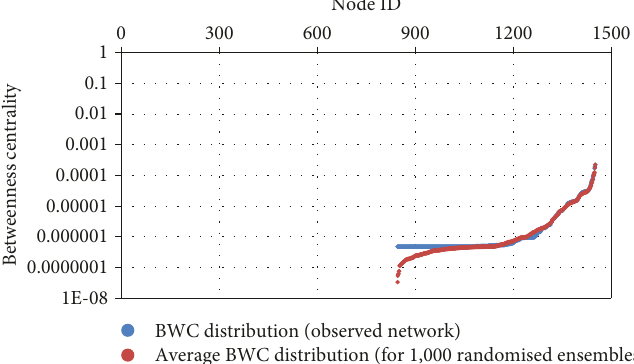
Figure 4: Betweenness centrality distribution of the observed SCN (ref #: 26 — Farm Machinery and Equipment) against the average betweenness centrality distribution obtained from 1000 randomised ensembles.